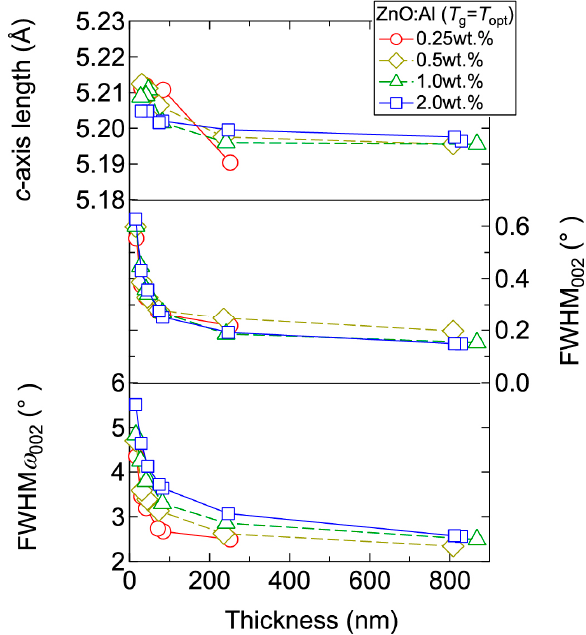
Figure 5. Plots of c -axis length, the FWHM of the 002 diffraction peak (FWHM 002 ), and the FWHM of rocking curves for the 002 diffraction peak (FWHM ω 002 ) as a function of thickness for ZnO:Al (0.25, 0.5, 1.0, and 2.0 wt %) films.